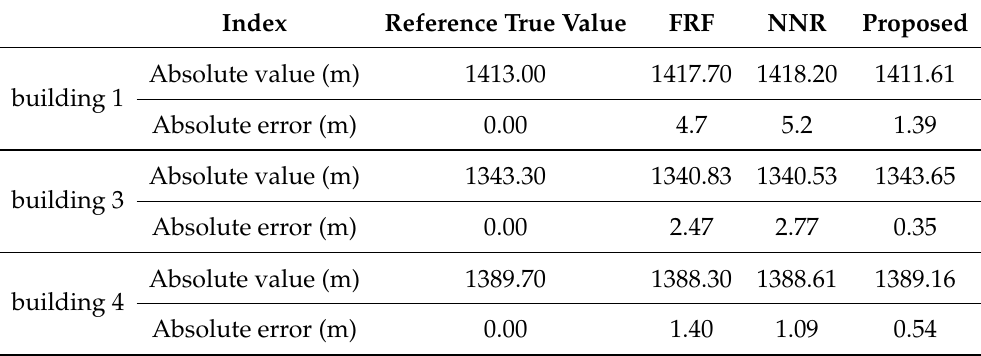
Table 4. Reconstruction performance in Experiment